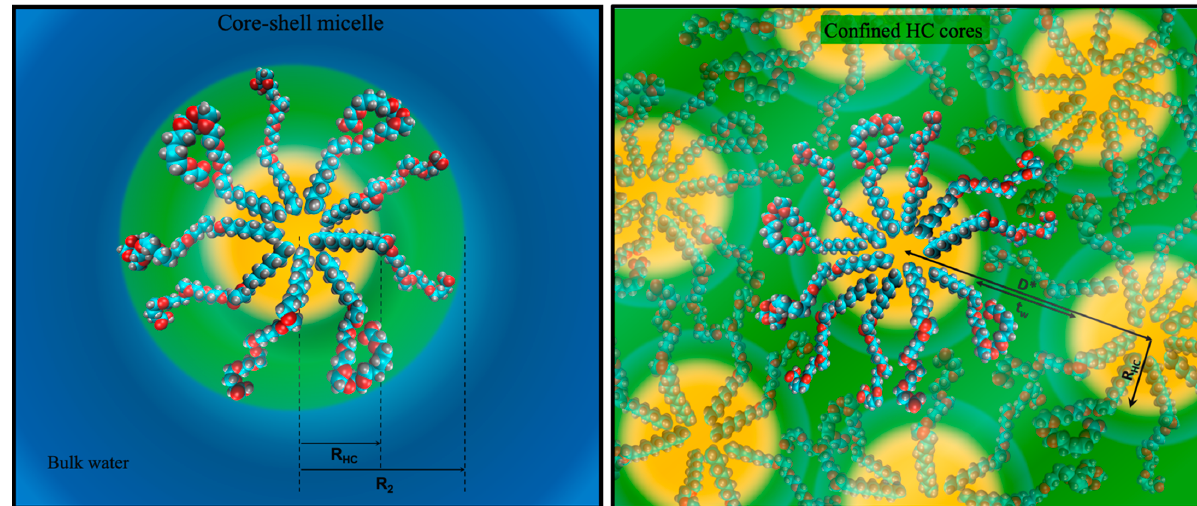
Figure 5. Scaled sketch of the two regimes observed in binary [H][C8E8c] water solutions. Left: the common core-shell structuring of direct micelles: a hydrocarbon core (R HC = 1.2 nm, shown in yellow) is surrounded by a hydrated ethylene glycol shell (shown in green); the bulk represented in blue contains monomers at cmc. Right: the confined hydrocarbon core (HC) regime observed in water-poor solution with interdigitated headgroups and the absence of bulk water; in this regime, the interparticle distance gives a scattering peak at D* = 2 π /q max . As can be inferred from osmotic pressure measurements, the compression of the water-poor ethylene glycol layer (t w ) is responsible of the stability of the structure. The figure was reused from Reference [16] (Copyright © 2021 Elsevier Inc.).